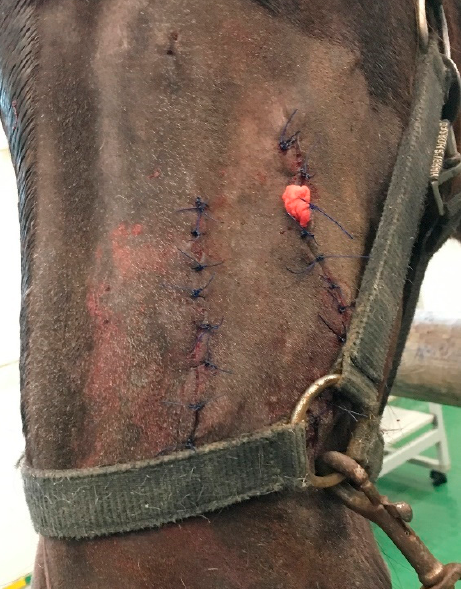
Figure 6. Extracted Triadan 208, fragment of the nasal bone, excised mass: ( a ) lateral site, ( b ) medial site. The skin and subcutaneous tissues were sutured as previously described (Figure 7). Part of the mass was sent for histopathological examination.